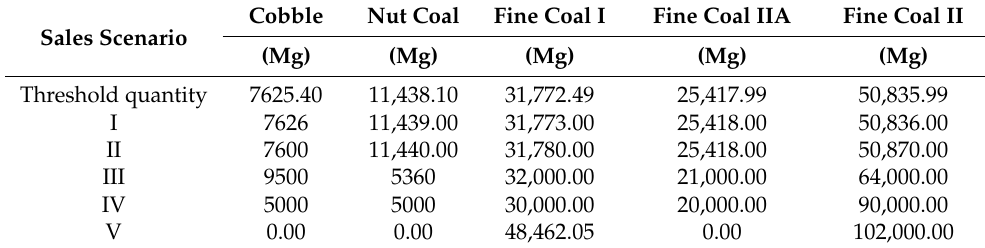
Table 6. Variants of sales of size grades of coal of mine "X" on a monthly basis (Mg). Cobble Nut Coal Fine Coal I Fine Coal IIA Sales Scenario (Mg) Threshold quantity